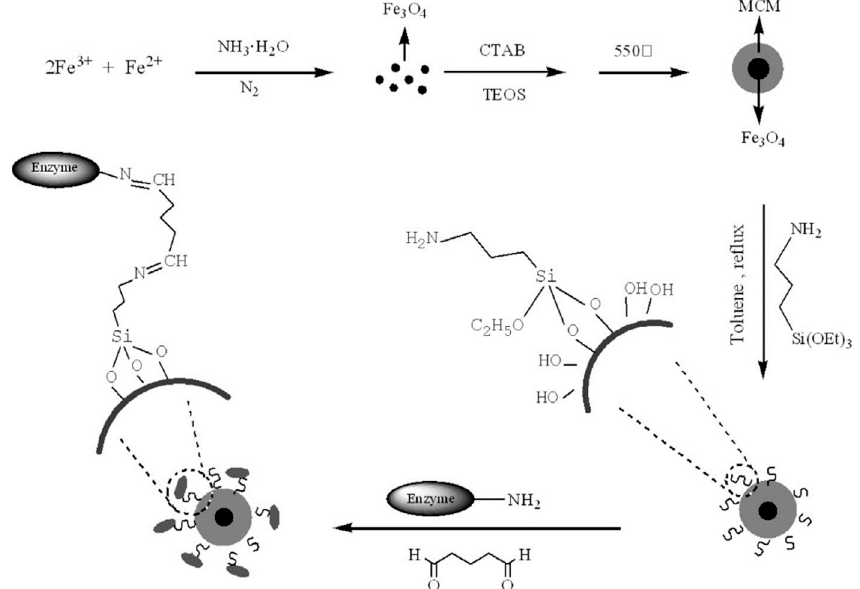
Figure 67. Synthesis of the magnetic MCM-41 immobilized Candida rugosa lipase. Reproduced with permission from [173]. Copyright 2016 Springer.